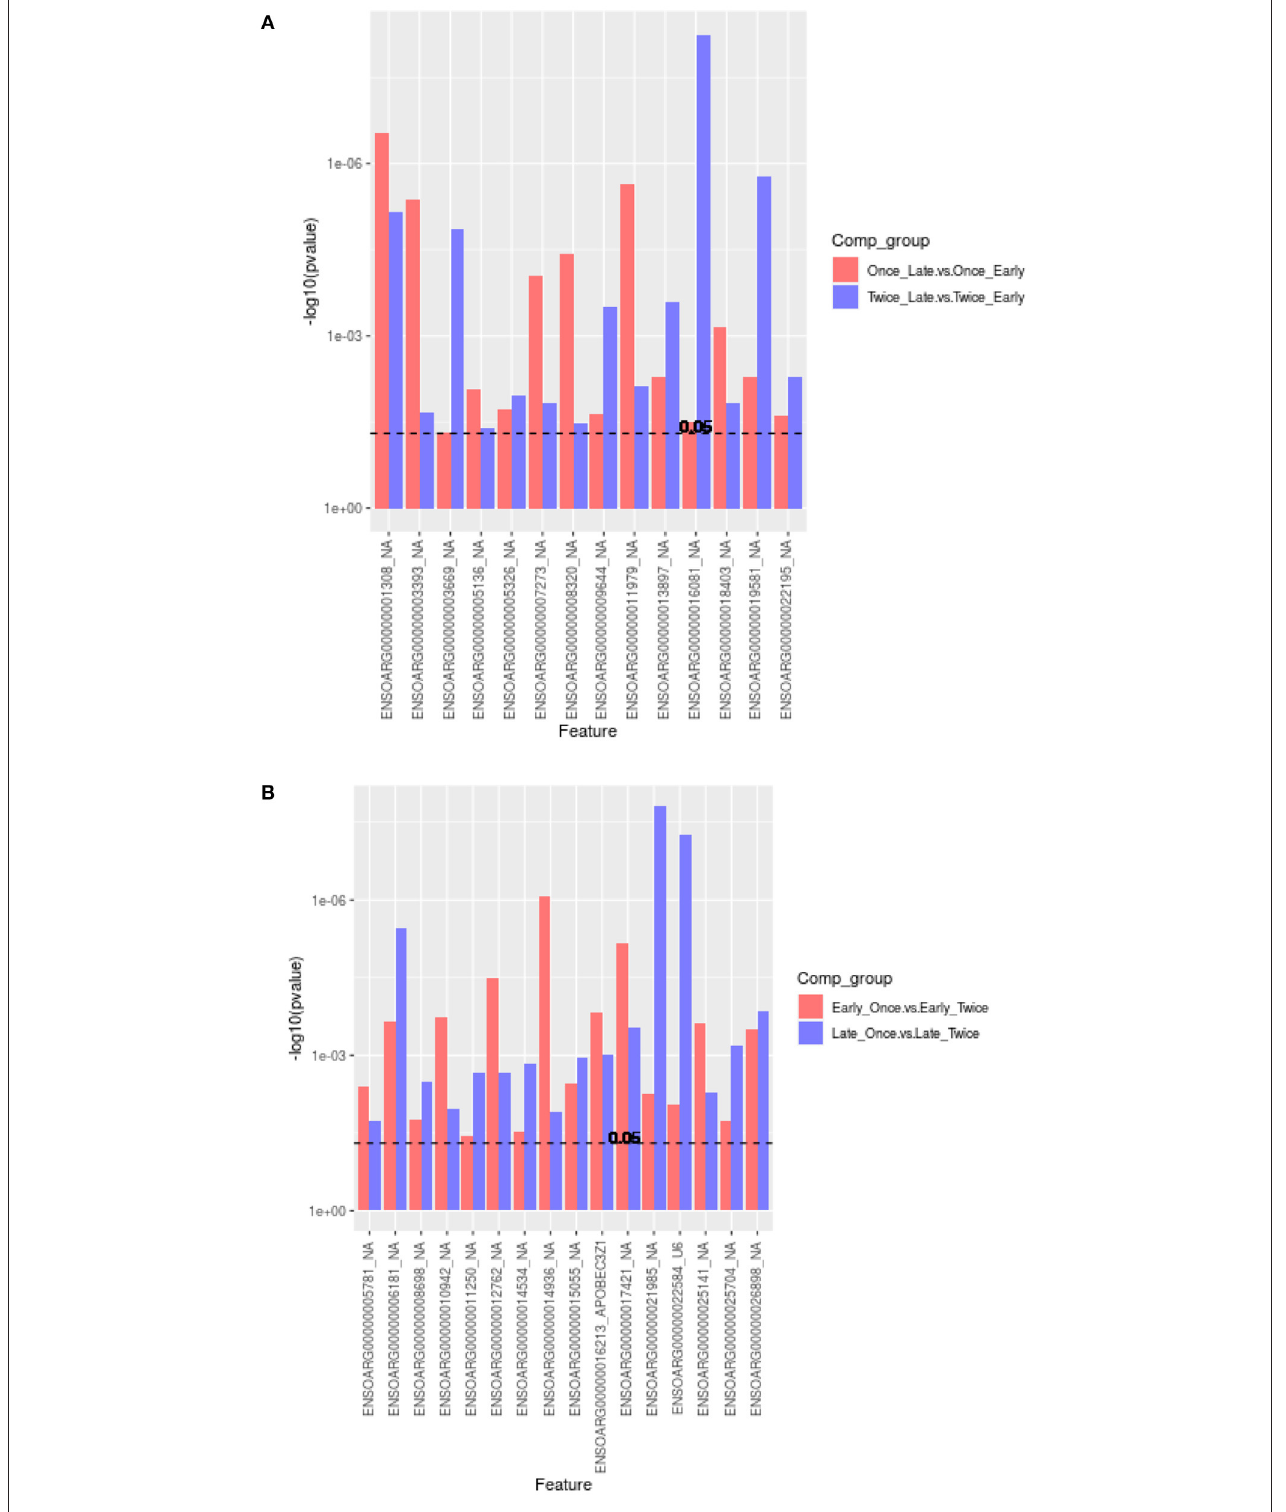
FIGURE 6 | Bar graph plot showing the annotations and significantly different overlapping methylation sites (in reference to the Venn diagrams, Figures 5A,B ). (A) A total of 14 (8/6) loci were upregulated or downregulated for comparisons of pregnancy scanning for once or twice sheared sheep. All loci have not a gene symbol (NA, not available). (B) In total, 22 (12/10) loci were upregulated or downregulated between shearing treatment including APOBECC3Z1 gene and